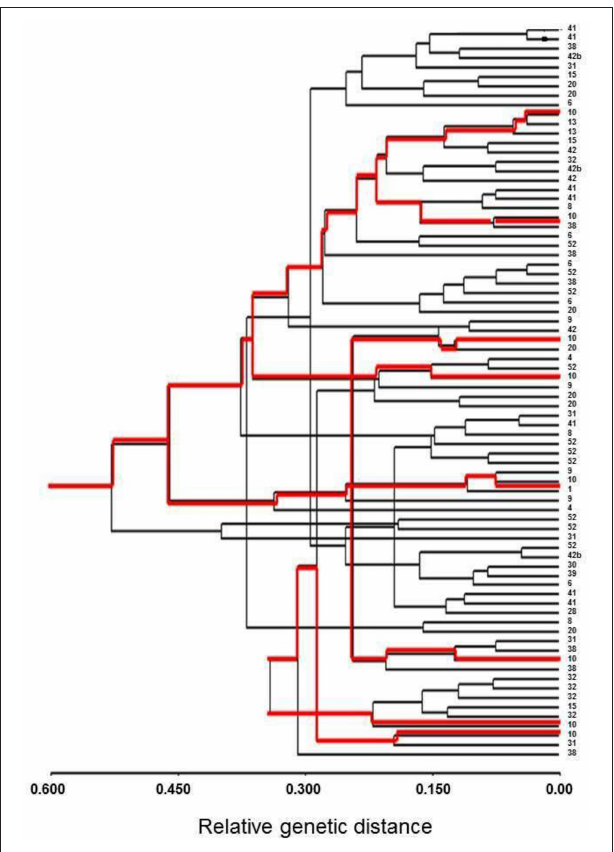
FIGURE 2 | Cluster analysis (UPGMA) of Lubim seedlings ( n = 78 ). The numbers on the right present the seedling group number; the red lines show eight individuals belonging to group